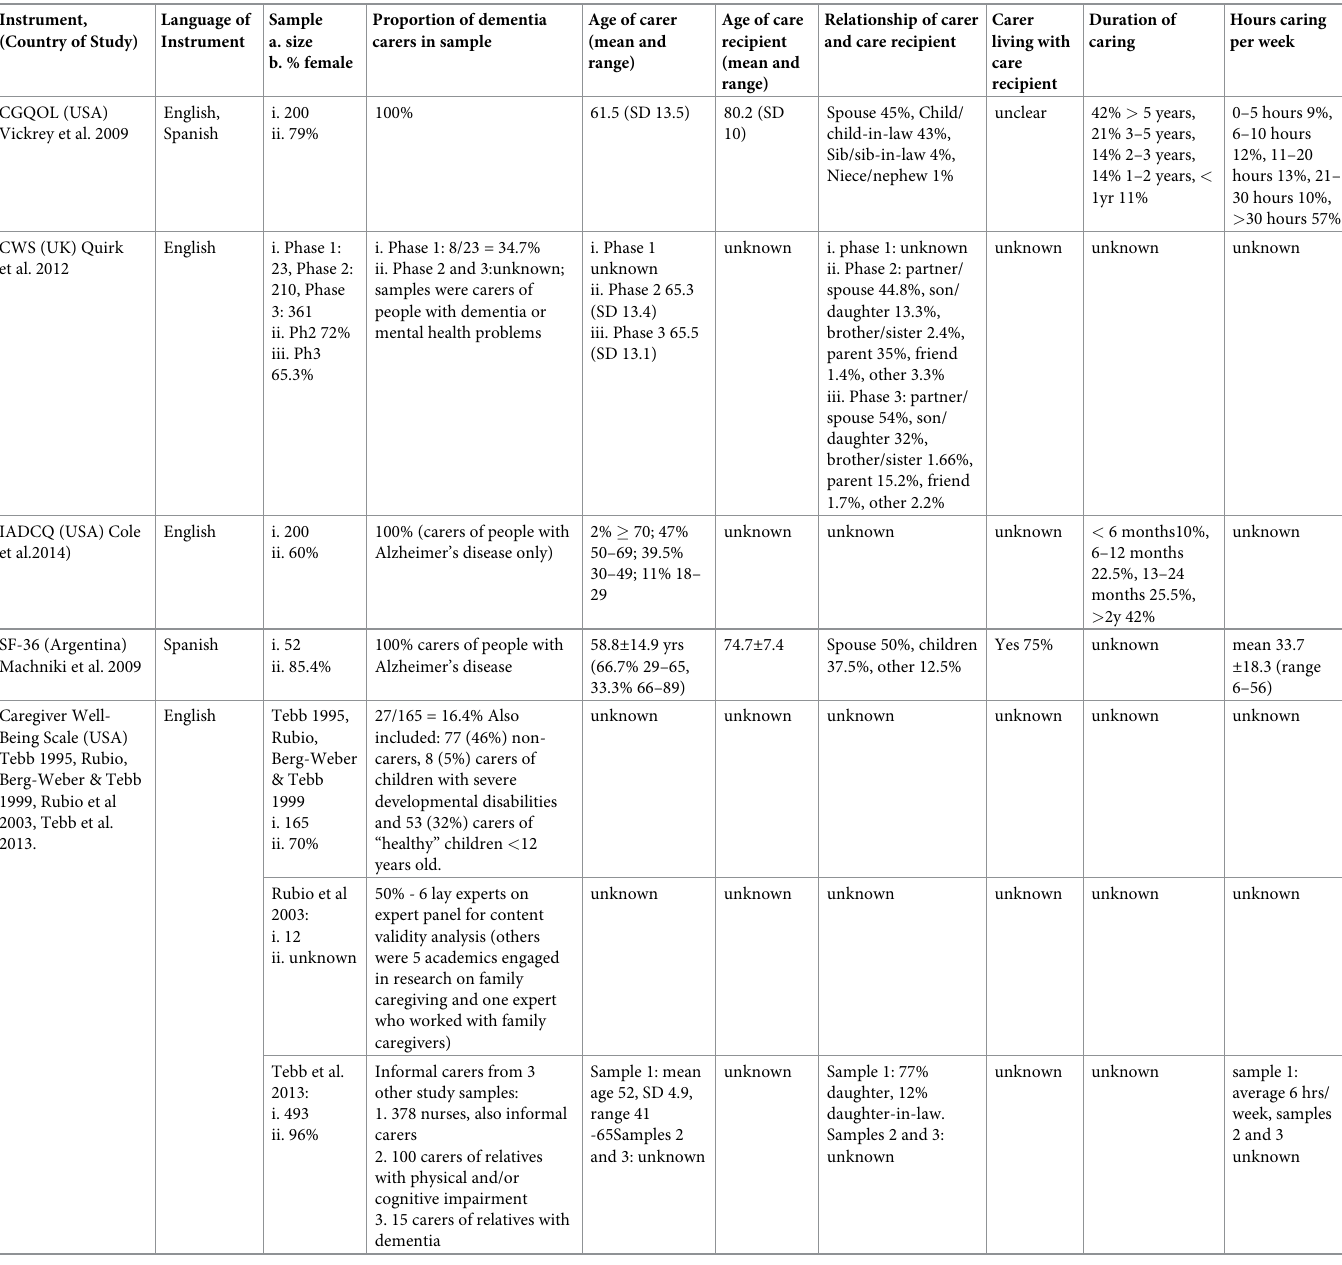
Table 4. Characteristics of included study populations. Instrument, (Country of Study)